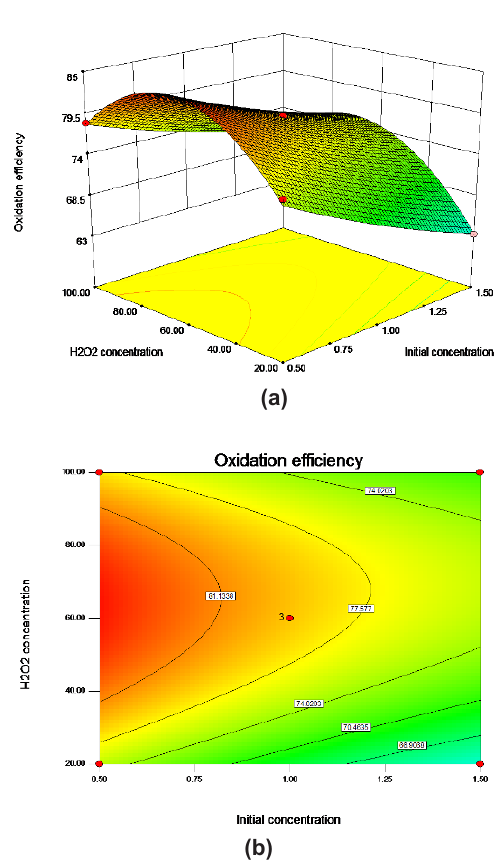
Figure 8. Effect of initial concentration of arsenite and H concentration on the arsenite oxidation efficiency with the power density at the zero level: (a) response surface and (b) contour plot of the predicted oxidation